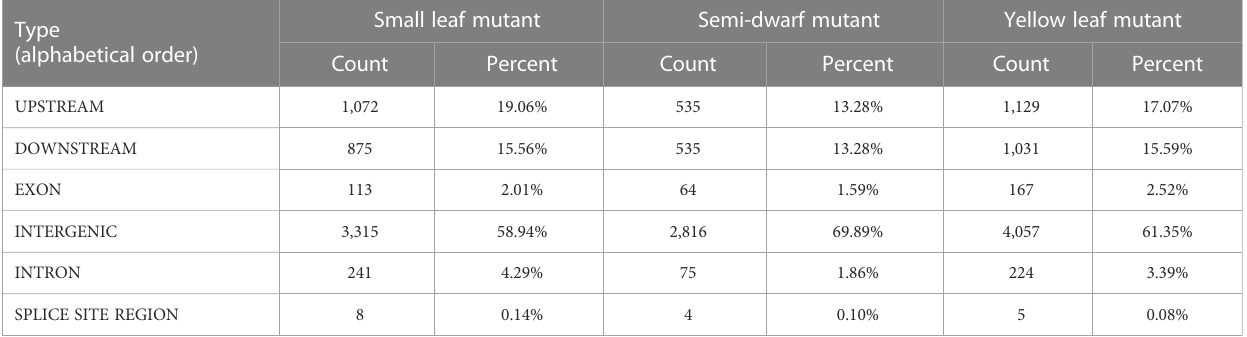
TABLE 2 The locations on the genome of SBS mutations induced by CIB